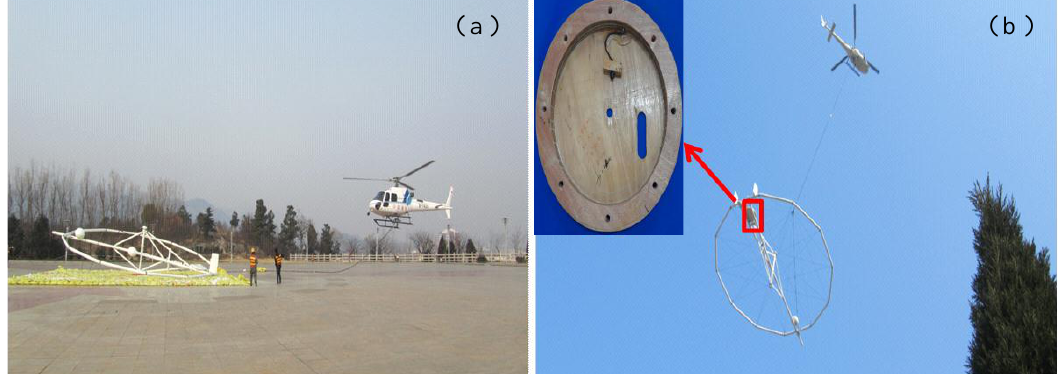
Figure 12. ( a ) Location site of the helicopter TEM system; ( b ) example of a helicopter